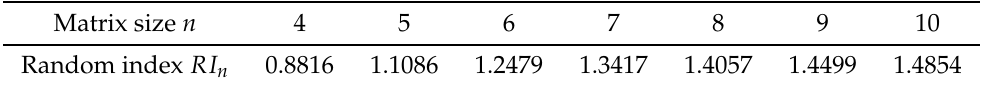
Table 1. Random index RI n values